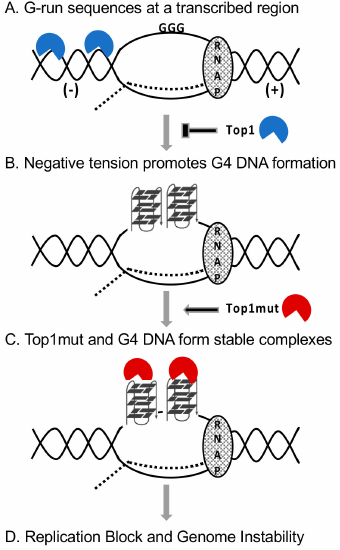
Figure 2. A model of genome instability induced by co-transcriptionally formed G4 DNA and the e ff ect of Top1 activity and mutation. RNAP—RNA polymerase complex. Dotted line—the nascent transcript. ( − )—negative tension behind the transcription complex. ( + )—positive tension ahead of the transcription complex. Top1mut—Top1